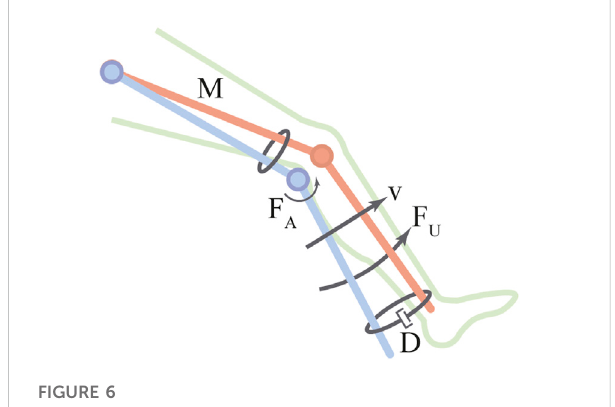
FIGURE 6 Schematic of mass-damper